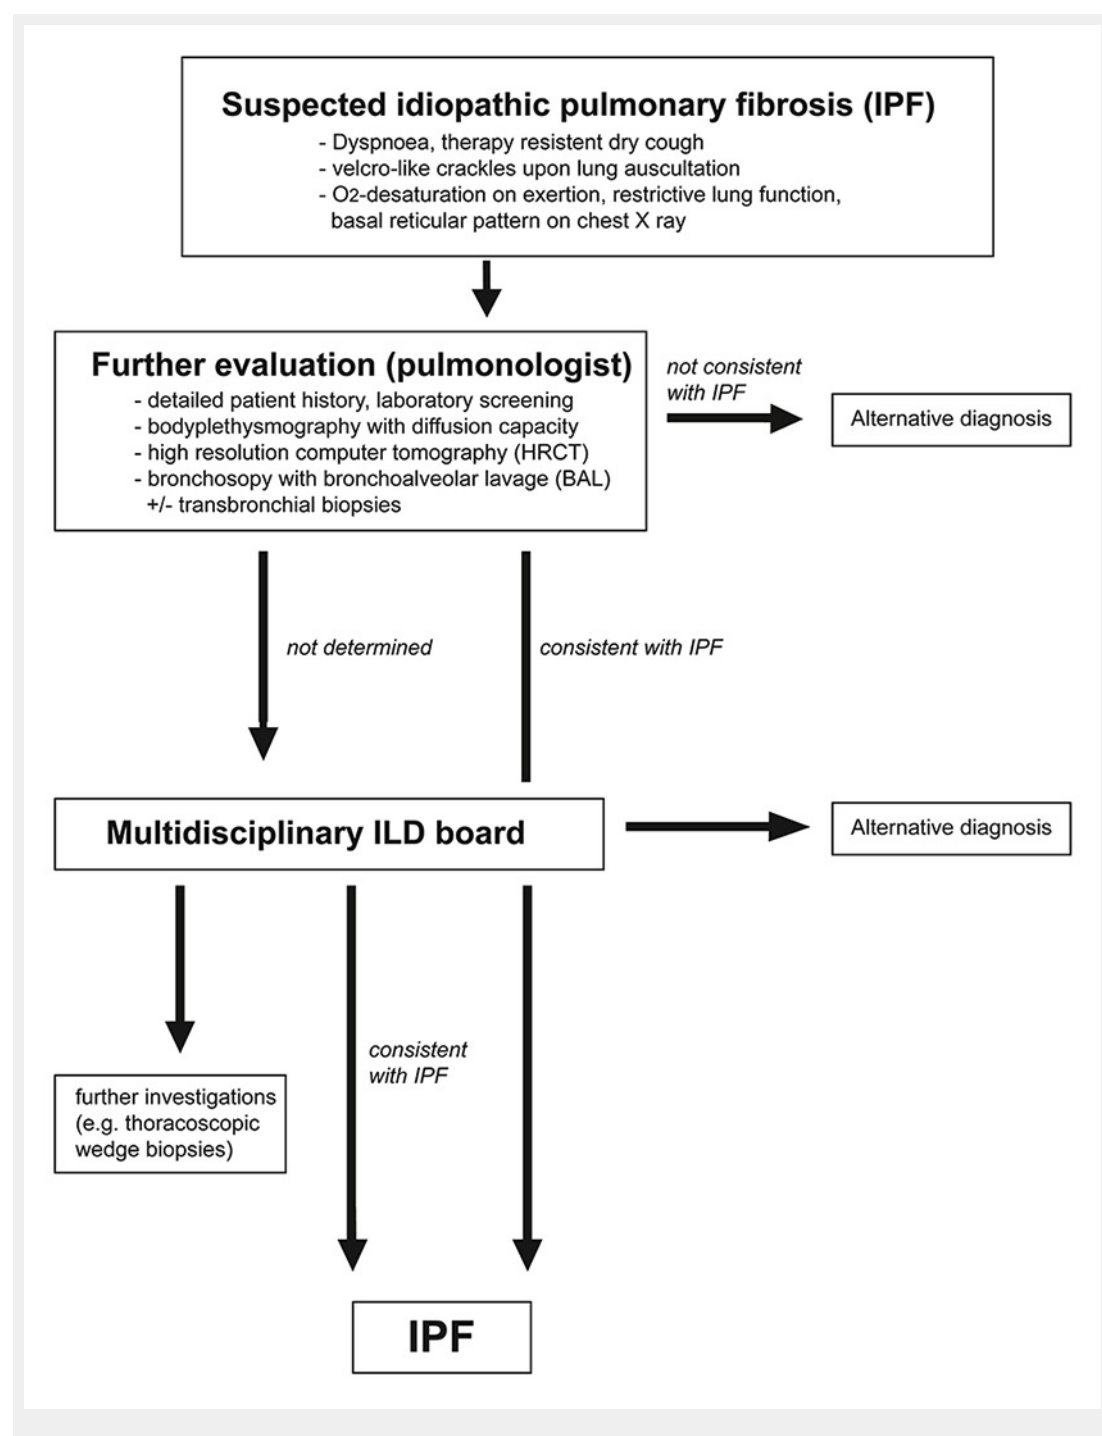
Figure 4 Diagnostic algorithm for suspected idiopathic pulmonary fibrosis. In the case of suspicion the patient is evaluated by an experienced pulmonologist. High-resolution computed tomography and bronchoalveolar lavage are performed. If the diagnosis is not clear the patients are discussed at a multidisciplinary interstitial lung disease (ILD) board and further diagnostic steps are taken if indicated (modified from